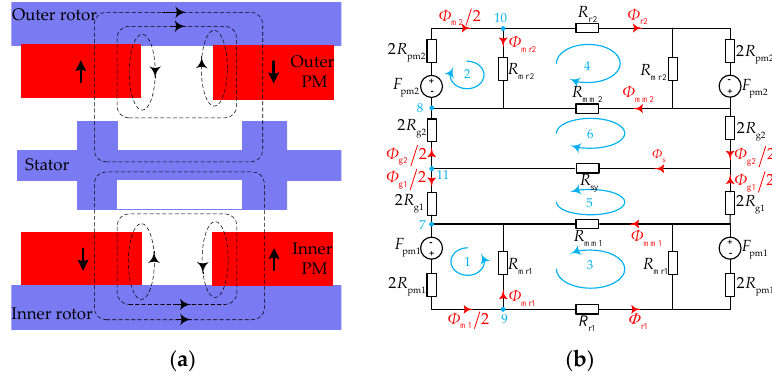
Figure 2. The linear translational topology and the corresponding equivalent magnetic circuit (EMC) of the DRRF wind generator: ( a ) The linear translational topology; ( b ) The corresponding EMC.